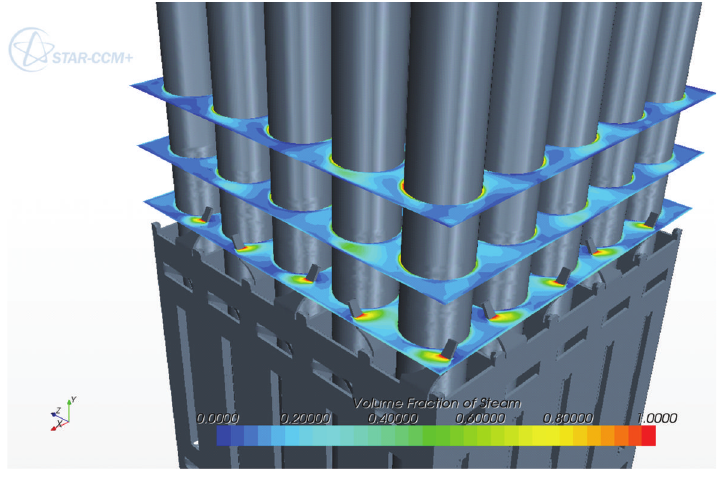
Figure 6: Void fraction.